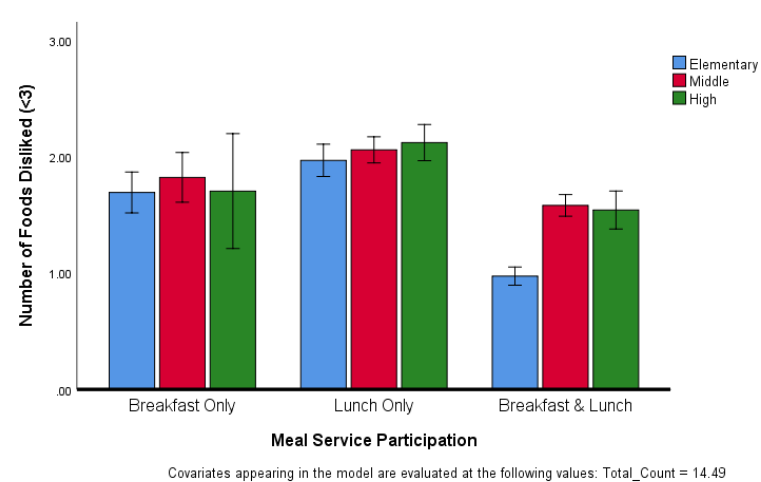
Figure 3. Number of foods disliked, adjusted for number of foods tried, by different age groups within meal service participation. Values are means with 95% CI indicated by vertical bars.